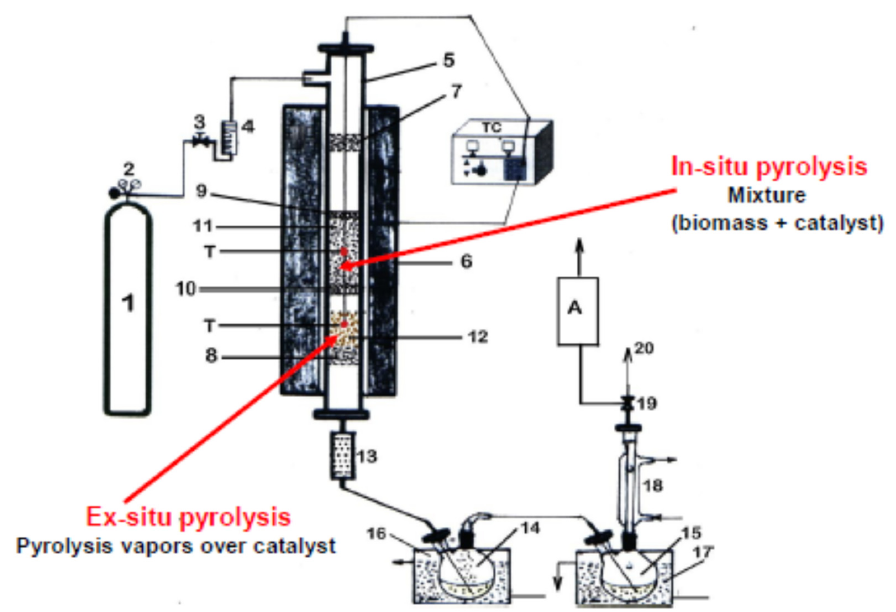
Figure 3. The scheme of experimental system used for biomass in situ, ex situ and combined pyrolysis process. (1)—tank of N 2 gas under pressure; (2)—pressure gauge; (3)—control valve; (4)—flow-